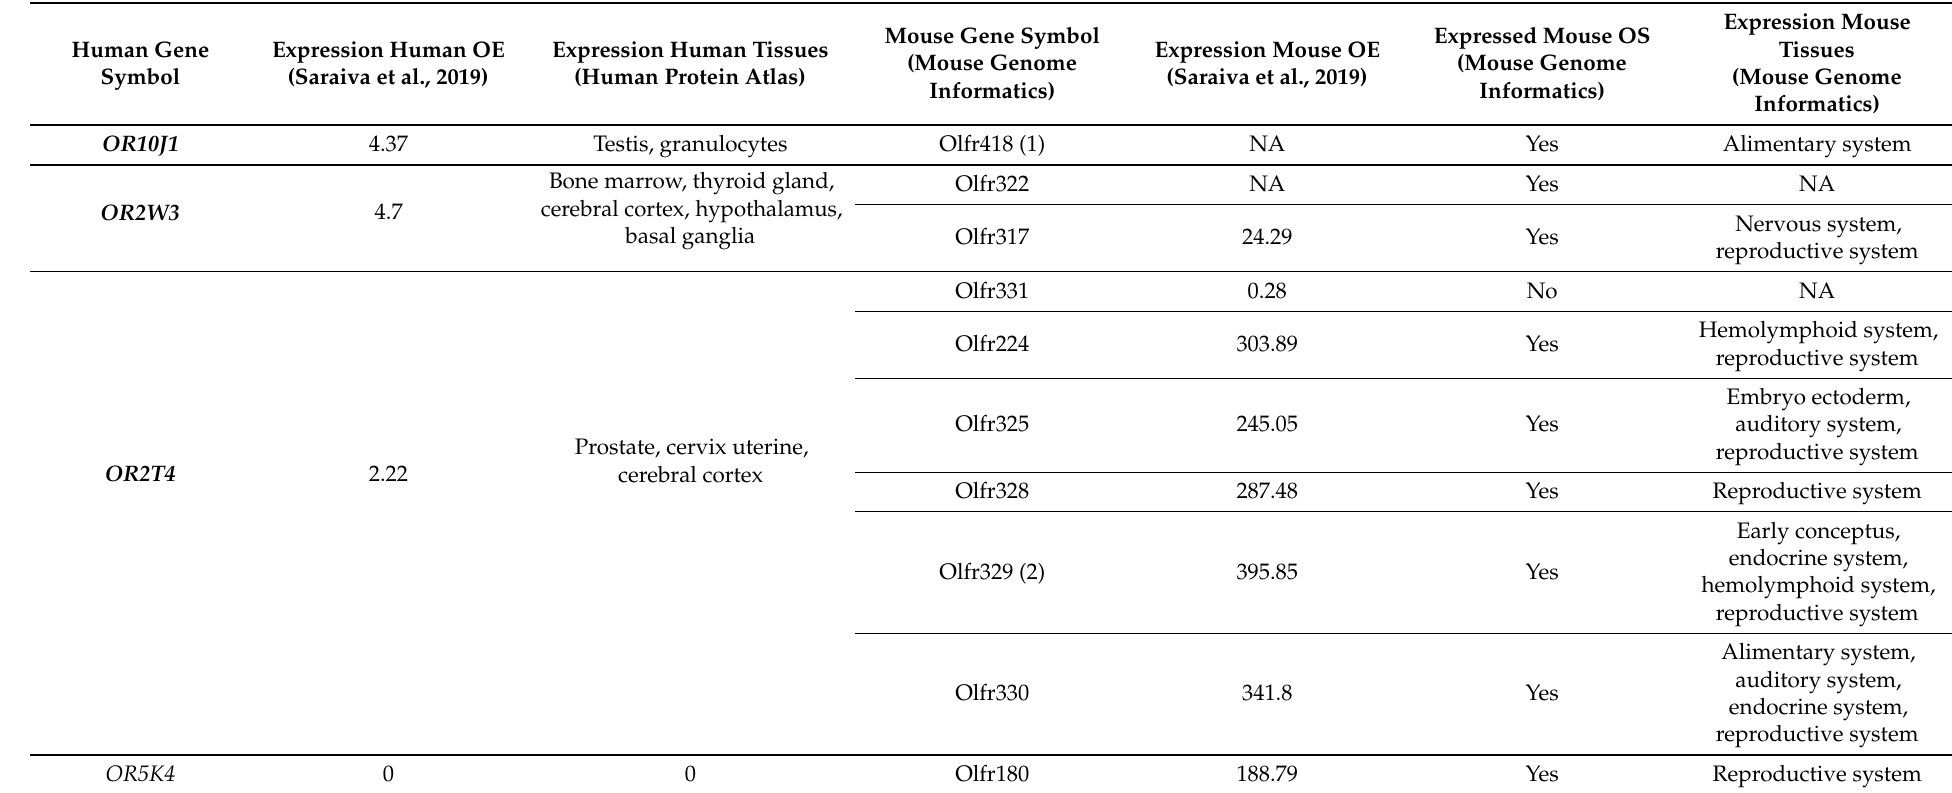
Table 3. Expression patterns of the OR-KO genes in different human and mouse tissues. The genes with robust expression (>1 NCs, NC = normalized counts) in human OE are indicated in bold. Expression human OE: average expression across three human OE samples from [37] measured as NC. Expression human tissues: list of tissues with expression above 1 NX (NX = Normalized eXpression) reported in the HPA (Human Protein Atlas); 0: no tissue with expression above 1NX; NA: gene not found in database. Mouse Gene Symbol: most likely mouse homolog identified through the MGI (Mouse Genome Informatics) database; note that each human OR gene can be associated to one, multiple, or no homolog (in this case NA). Expression Mouse OE: average expression across three mouse OE samples from [37] measured as NC. Expressed Mouse OS indicates whether MGI reports expression in a tissue of the